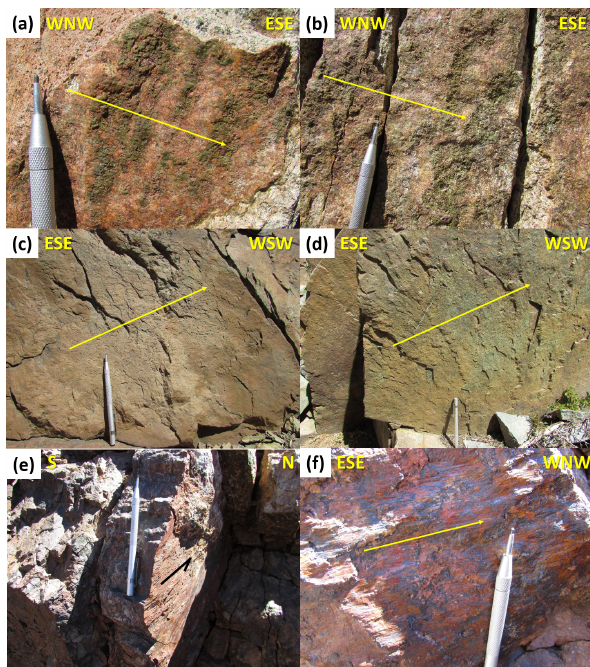
Figure 4. Fault planes in different branches of the PFS. All of them show evidence of sinistral strike-slip movements. Arrows in- dicate the sense of movement of the missing block. Panels (a) and (b) correspond to fault planes affecting the Miocene plutons of the Carlota intrusive complex, with syn-tectonic epidote (a) and acti- nolite (b) forming steps and crystallizing in strain fringes. Pan- els (c) and (d) correspond to fault planes affecting volcanic rocks of the Teniente volcanic complex, with the sense of movement in- dicated by RM criteria (Petit, 1987). Panels (e) and (f) illustrate the syn-tectonic, quartz–barite–calcite–hematite San Pedro de Nolasco veins, with the sense of movement indicated by steps in quartz and